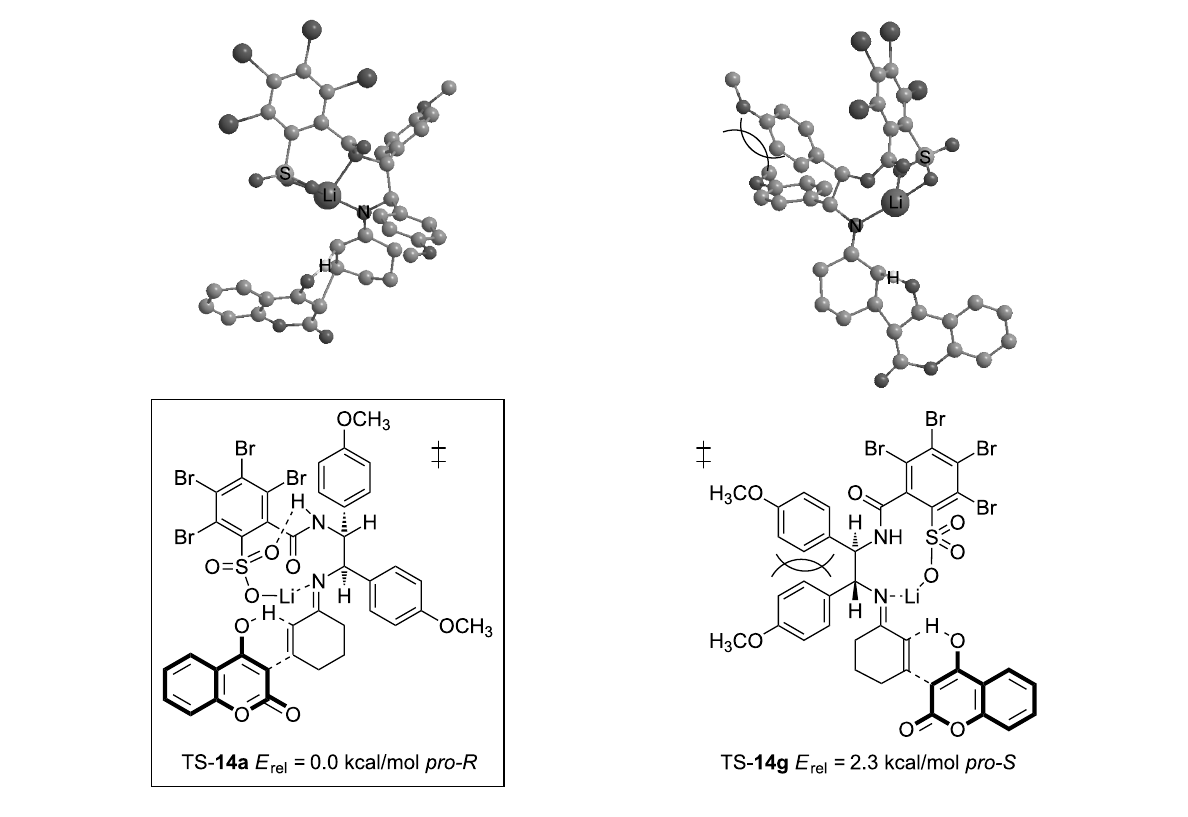
Figure 4: The competing enantio-determining transition structures TS- 14a and TS- 14g . The reason for the destabilization of 14g (most stable pro-S ) is the steric repulsion of anisyl groups in the backbone (TPSS/SVP+ZPE).